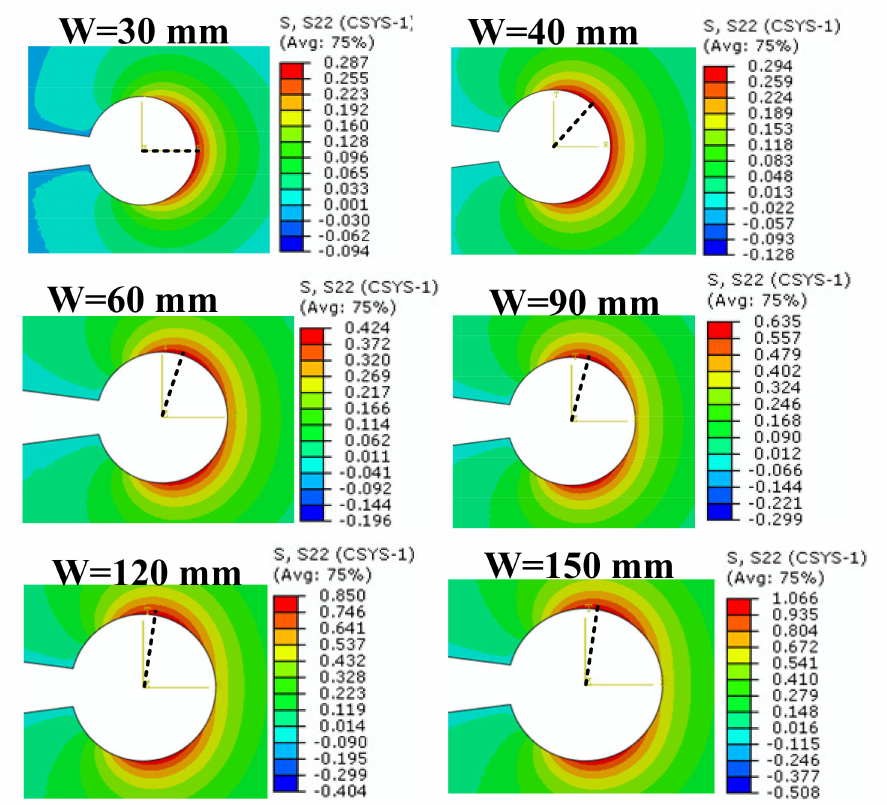
Figure 3. TS contours around VO-notches for FE models with various widths ( ρ = 2.5 mm, γ = 15 ◦ ).